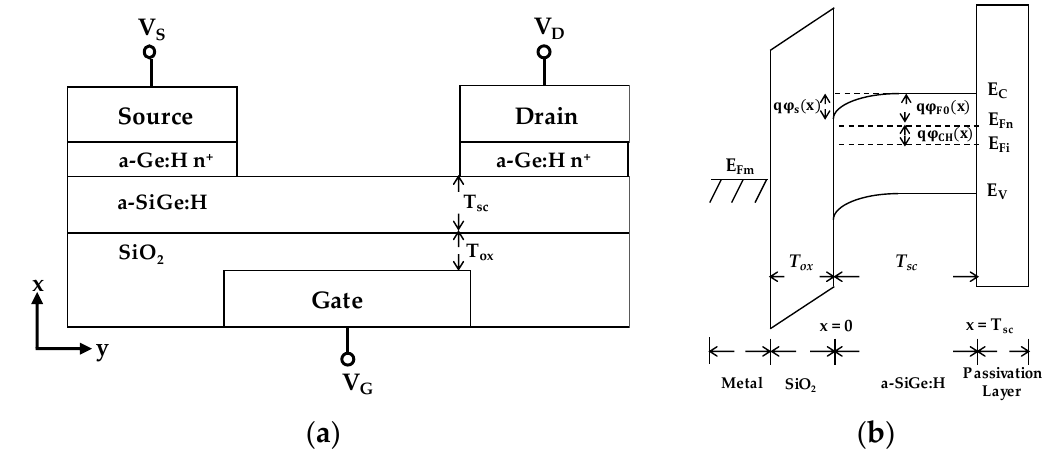
Figure 1. ( a ) Cross-section of a coplanar bottom-gate top-contact a-SiGe:H TFT; ( b ) equivalent energy band diagram of the MIS region of this device.